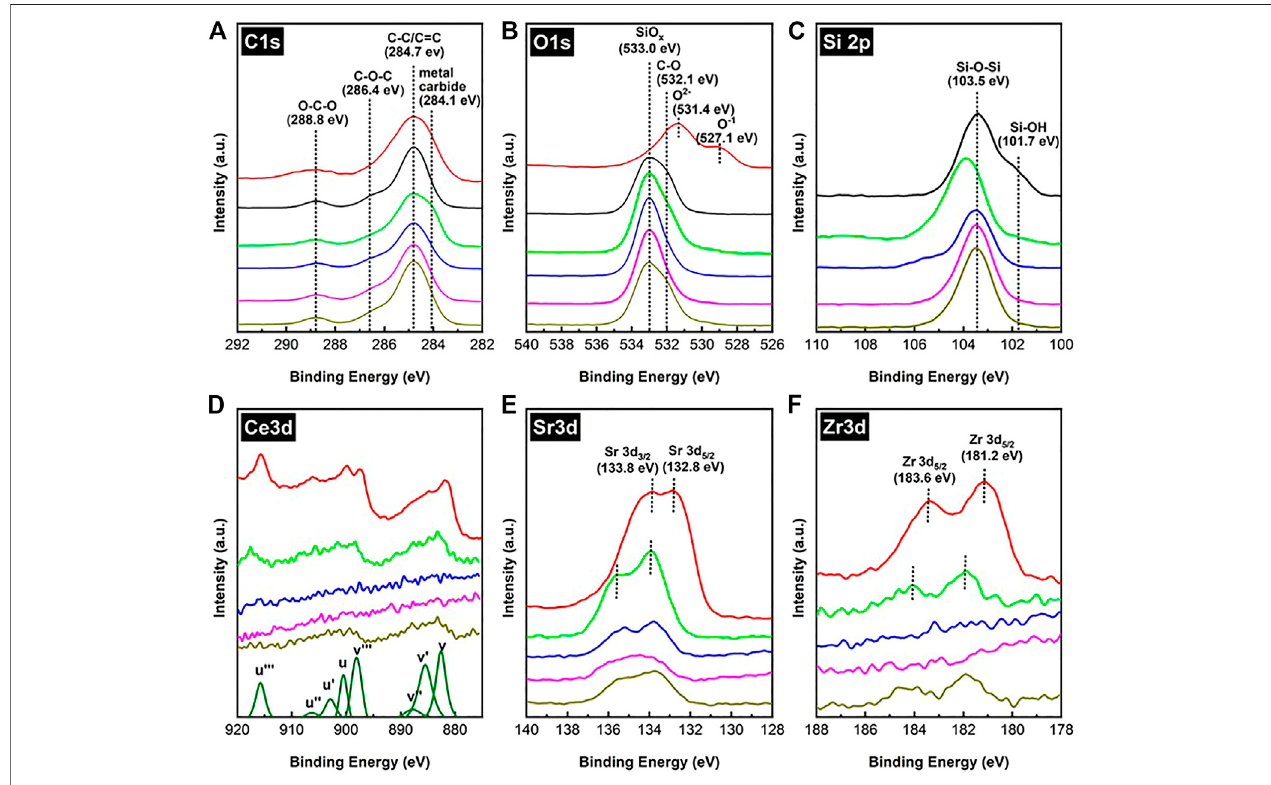
FIGURE9| XPSspectraofC1s (A) ,O1s (B) ,Si2p (C) ,Ce3d (D) ,Sr3d (E) ,andZr3d (F) offreshSCZO(red),freshFeSiO 2( black),spentFeSiO 2 mixedwithSCZOin 2:1 mass ratio (green), spent FeSiO 2 mixed with 5 wt% SCZO (blue), spent FeSiO 2 mixed with 5 wt% SCZO under 10% H 2 co-feed (purple), and spent FeSiO 2 mixed with 5 wt% SCZO under 20% H 2 co-feed (dark yellow),